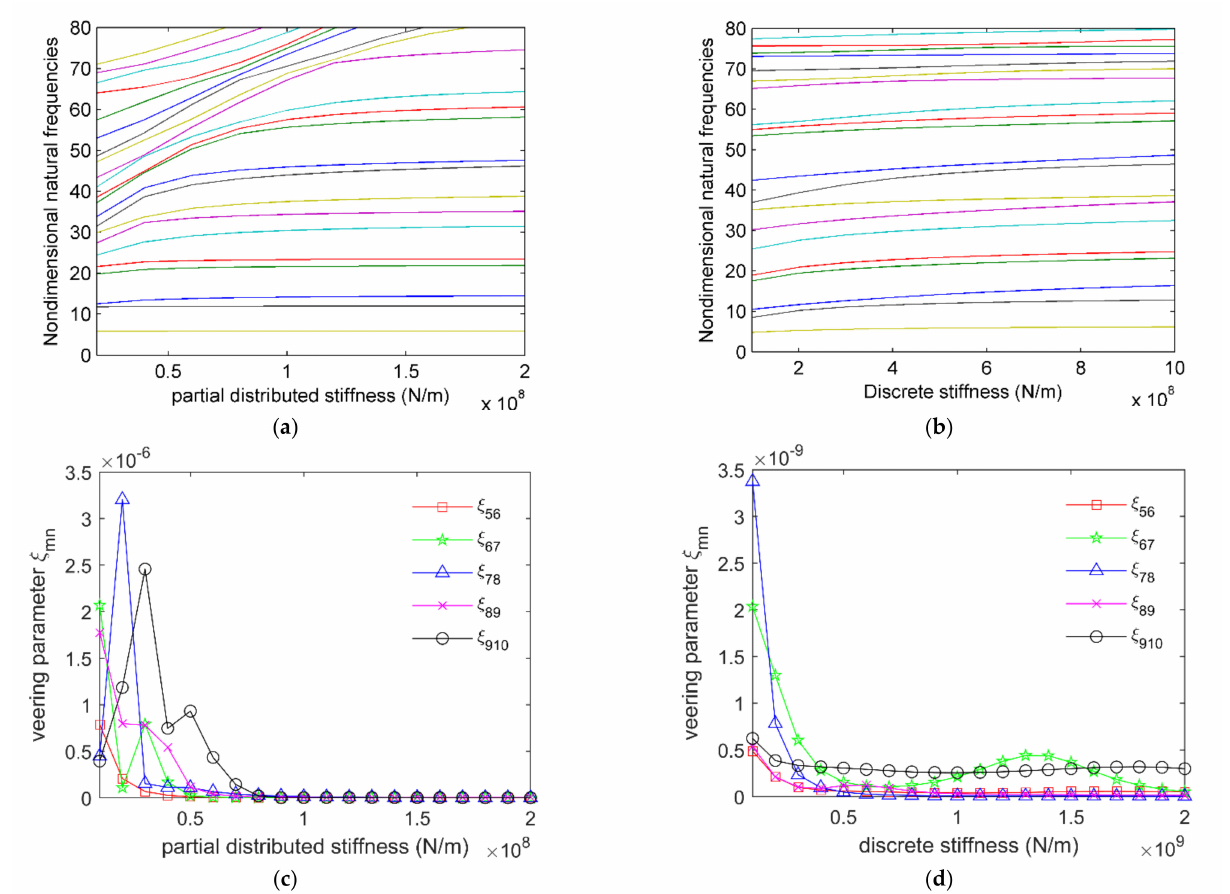
Figure 8. Influences of ( a ) partial distributed stiffness, ( b ) discrete stiffness to natural frequencies, ( c ) veering parameter ξ mn for ( a ), and ( d ) veering parameter ξ mn for ( b ) at ω =